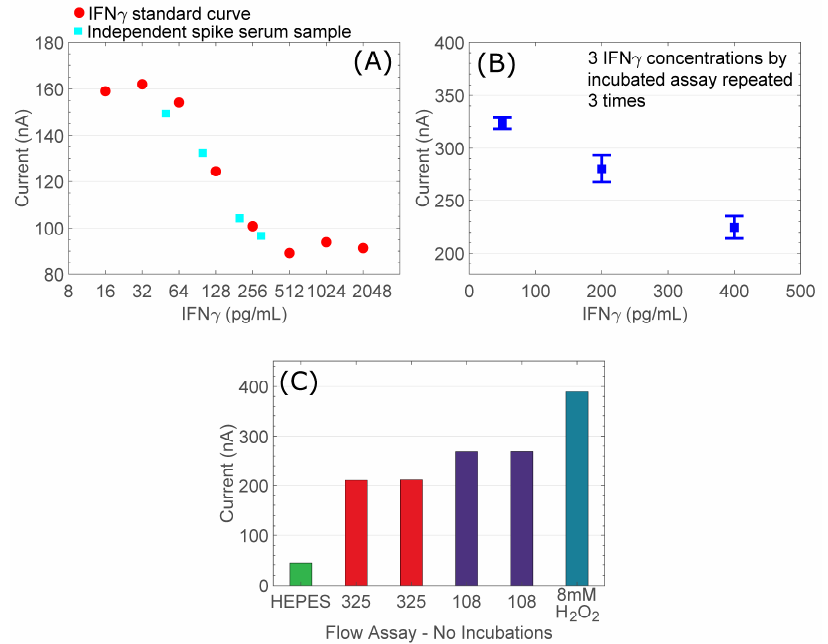
Figure 5. ( A ) Full IFNγ assay data generated using bespoke assay areas at the PCB surface (red circle), showing assay points from samples of IFNγ spiked into normal blood plasma (cyan square); ( B ) Three concentrations of IFNγ, each repeated three times; ( C ) IFNγ concentrations assessed by full flow assay protocol. All assay reagents are supplied under flow without any static incubation steps.